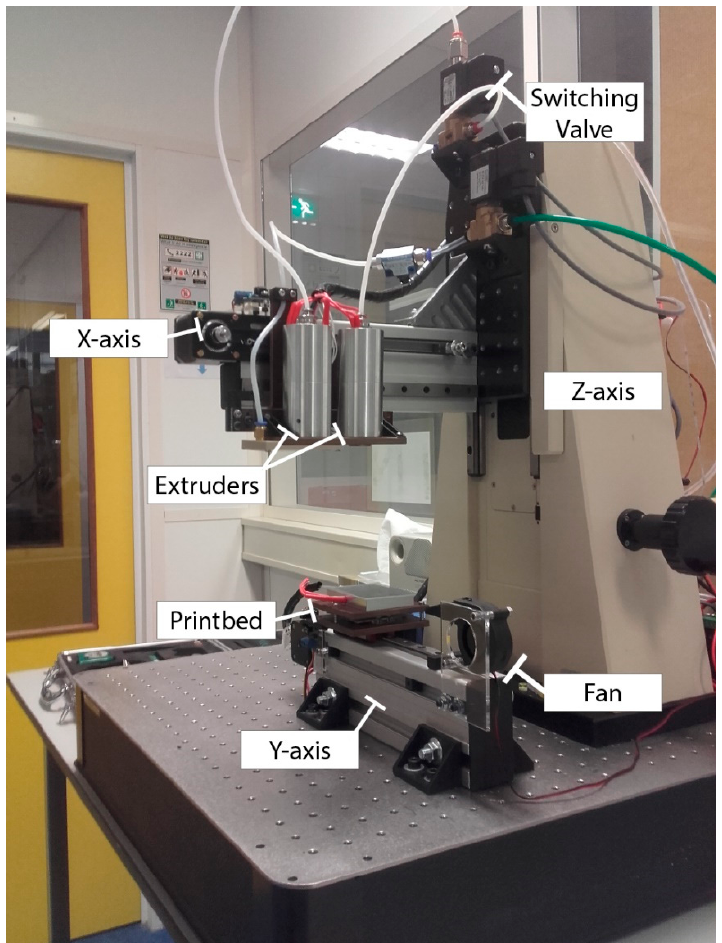
Figure 1. Dedicated 3D printer setup with pressure extrusion. Optical table has the Z and Y-axis mounted onto it, and the X-axis is mounted on the translation platform of the Z-axis. Y-axis consists of a belt driven slider with a vacuum chuck that can be levelled by three set screws and springs. X-axis has two extruders with two 40 W heater cartridges each. Extrusion can be switched using the valve mounted on the Z-axis and is controlled by a pressure controller (not shown in this figure). A fan is added to the end of the Y-axis to provide cooling of the extruded fibre during printing.